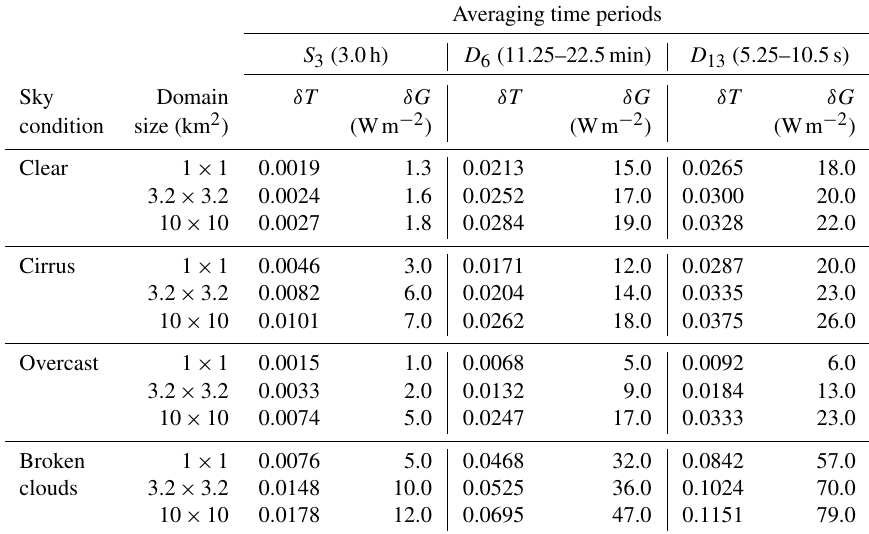
Table 6. Mean deviation between point measurement and spatial averages of global transmittance ( δT ) and corresponding global radiation ( δG , in Wm − 2 ) for different averaging time periods and domain